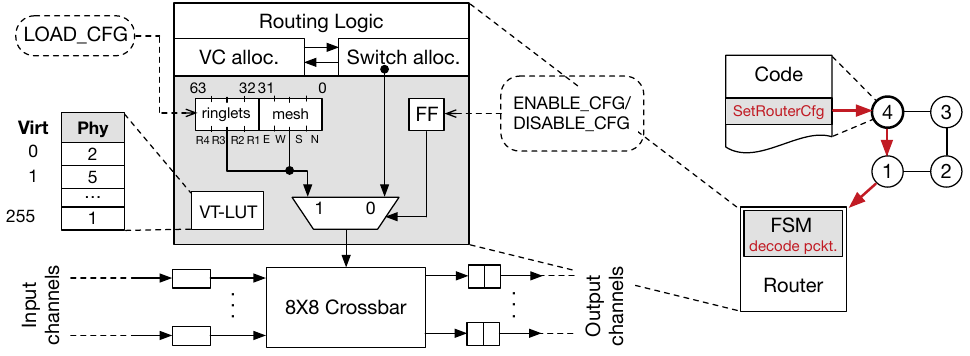
Figure 7. Router micro-architectural extension for supporting dynamic reconfiguration ( left ). An example of the reconfiguration flow is also depicted ( right